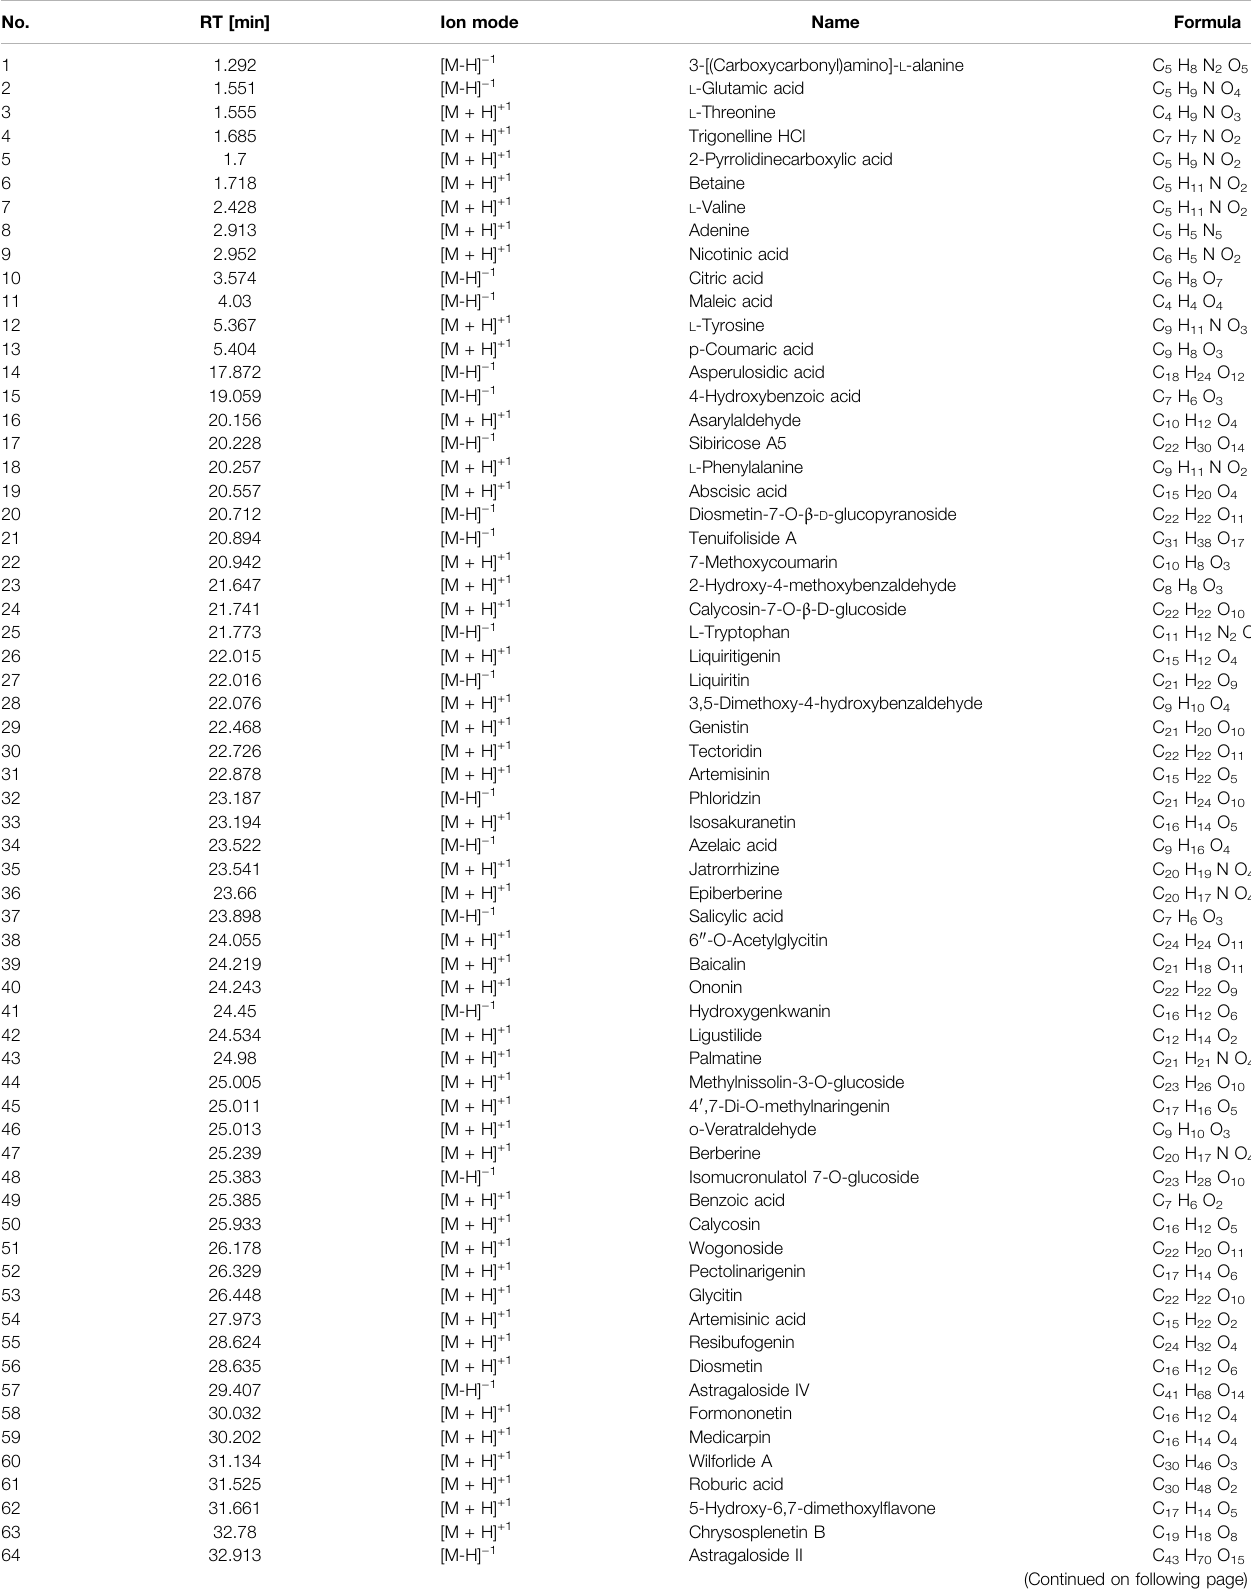
TABLE 1 | Information of compounds of compatibility of AMD and RTD with a ratio of 5 to 3 detected by LC-ESI-MS/MS in different Ion modes. No. RT [min] Ion mode Name Formula